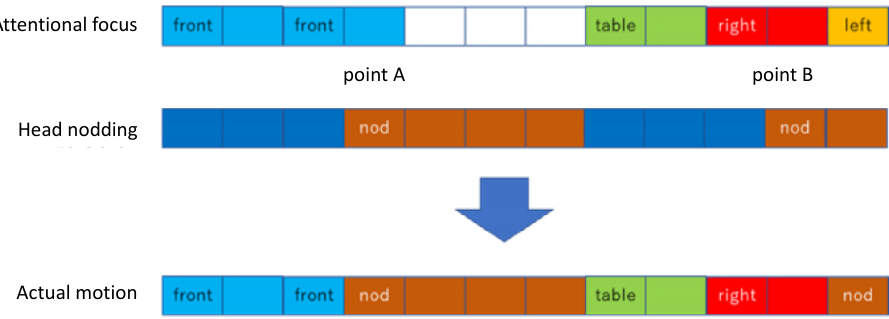
Figure 11. Conceptual diagram of the integration of the two proposed